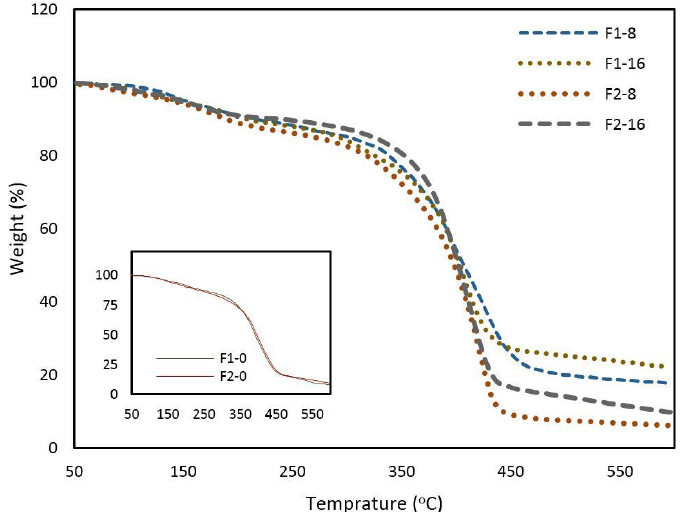
Figure 5. Thermogravimetric analysis (TGA) graph of weight change as a function of temperature for composite films from ASC-g-P(MMA-co-EA) with GO contents.